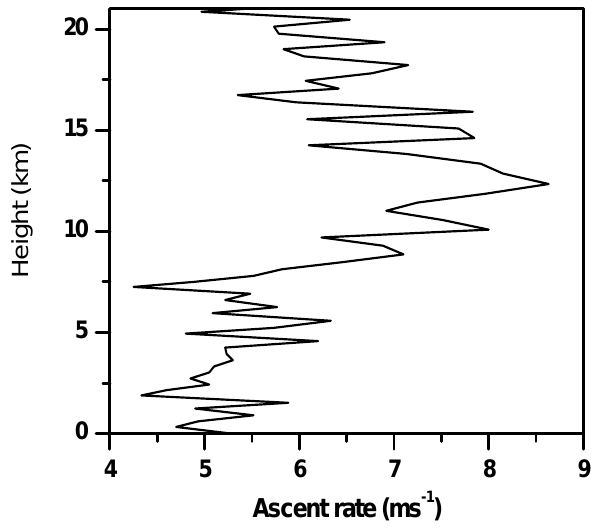
Fig. 1. Height profiles of balloon ascent rate on 2 September